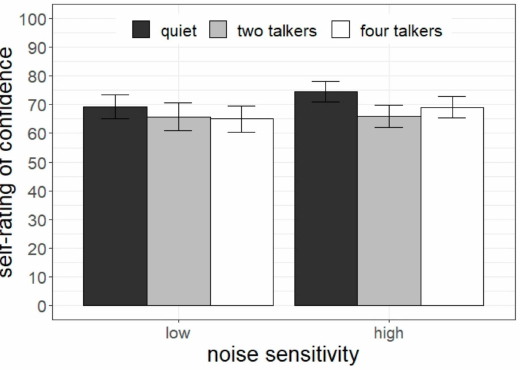
Figure 7. Subjective assessment of confidence as a function of students’ noise sensitivity and listening condition. Error bars indicate standard